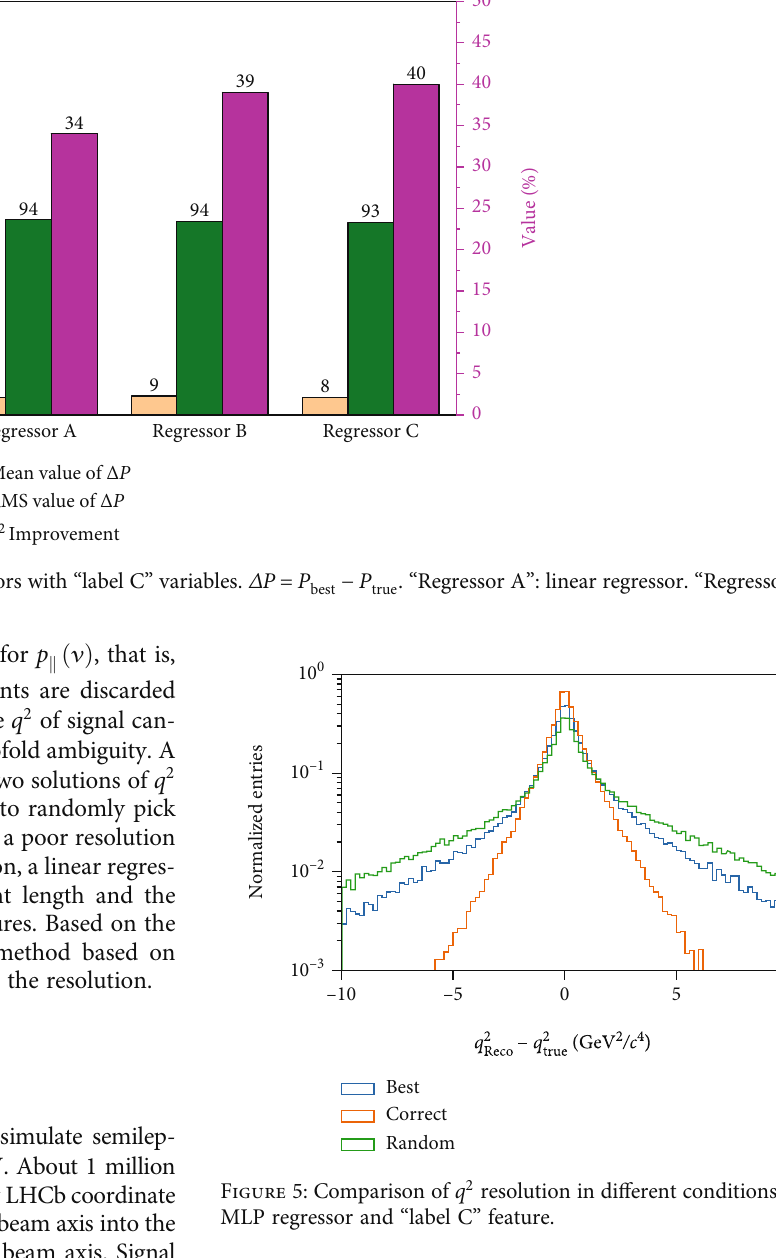
Figure 5: Comparison of q 2 resolution in di ff erent conditions with MLP regressor and “ label C ”